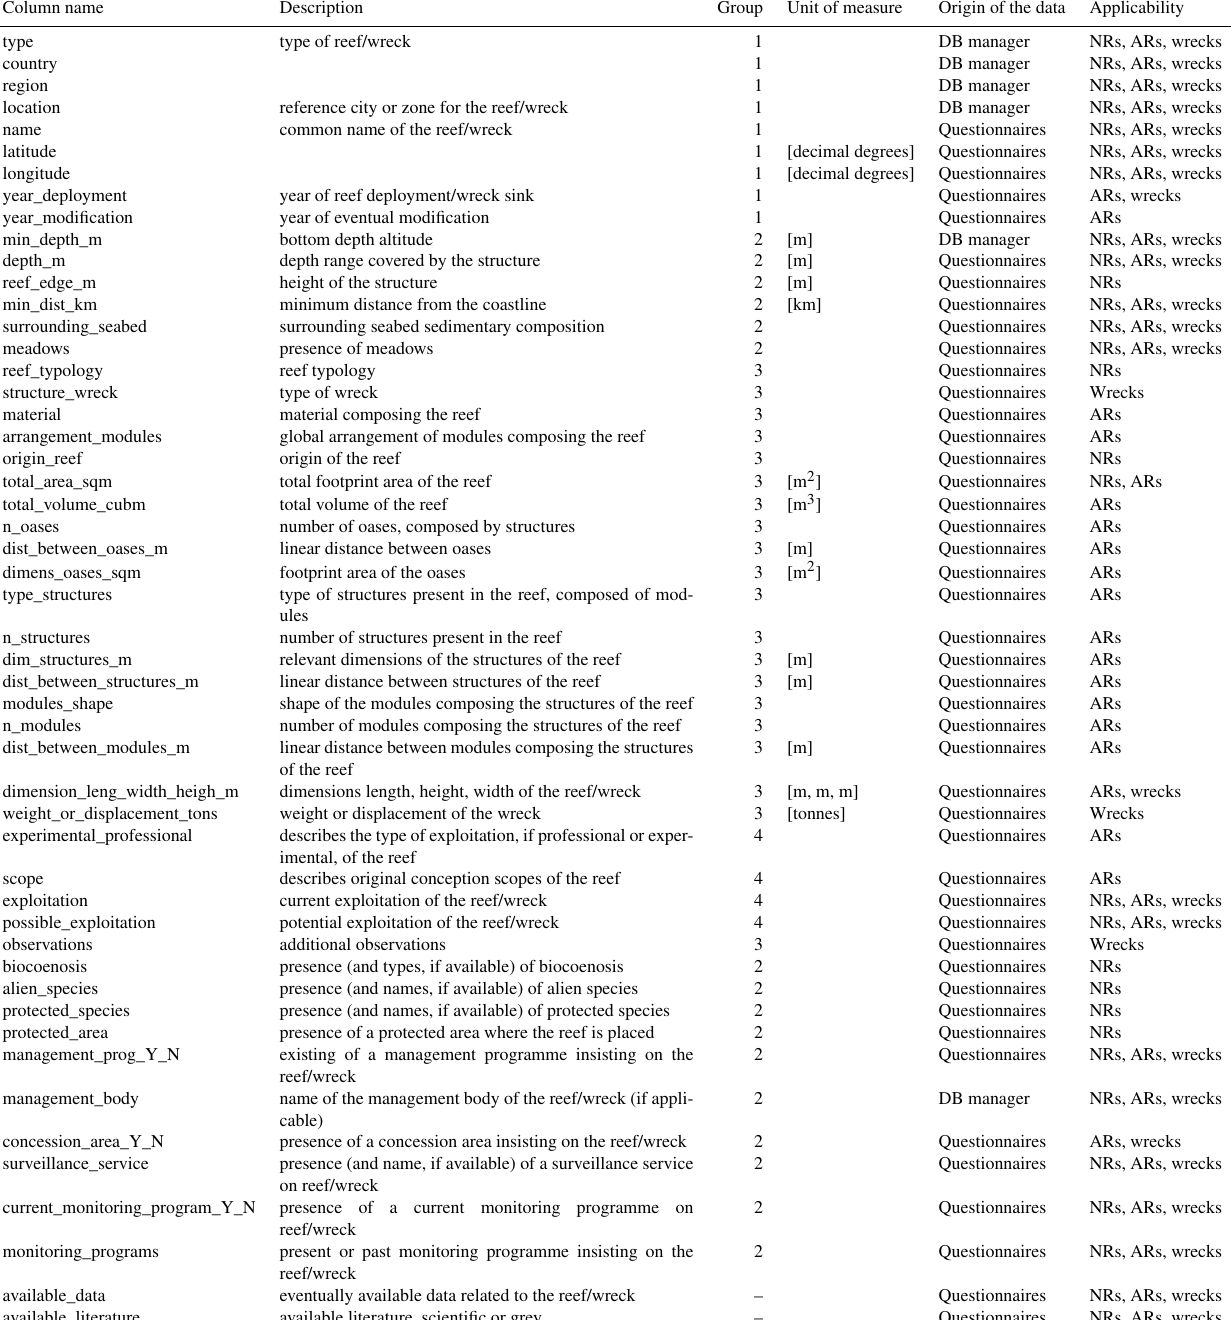
Table 2. Column name, the current name of the parameter, type of parameter, unit of measure, origin of the information, and eventual applicability